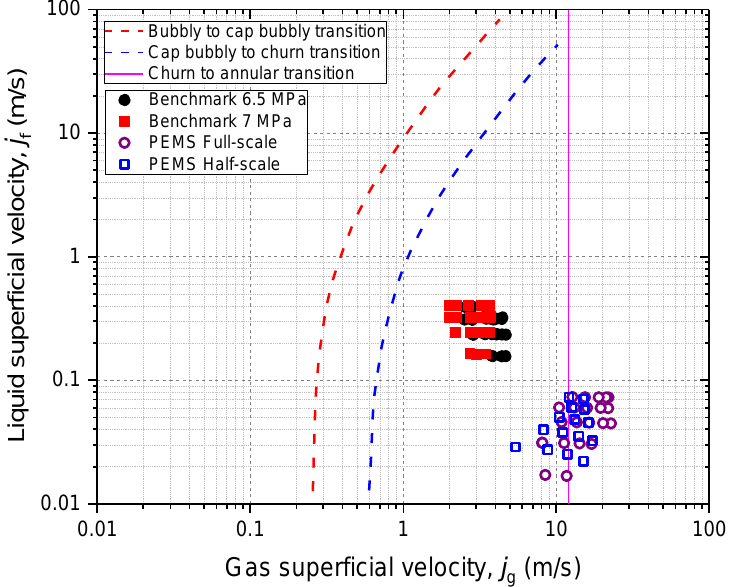
Figure 6. Two-phase flow regime map for benchmark test and air-water test